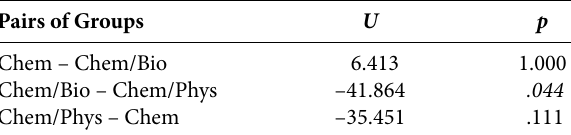
Table 4. Group comparison with post-hoc Mann–Whitney tests (two-tailed) in the chemistry teachers’ use of pre-laboratory activi- ties regarding teaching subjects Pairs of Groups